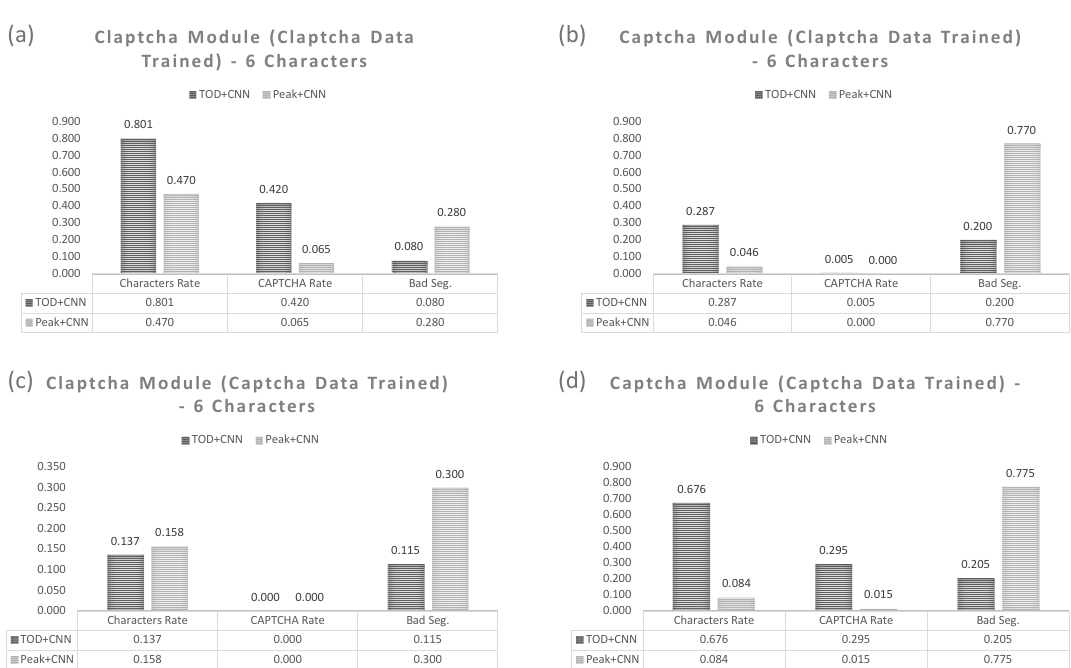
Figure 10. Test Results of Individually Trained Modules. ( a , b ) Only Claptcha data are trained to validate Claptcha and Captcha modules respectively. ( c , d ) Only Captcha data are trained to validate Claptcha and Captcha modules